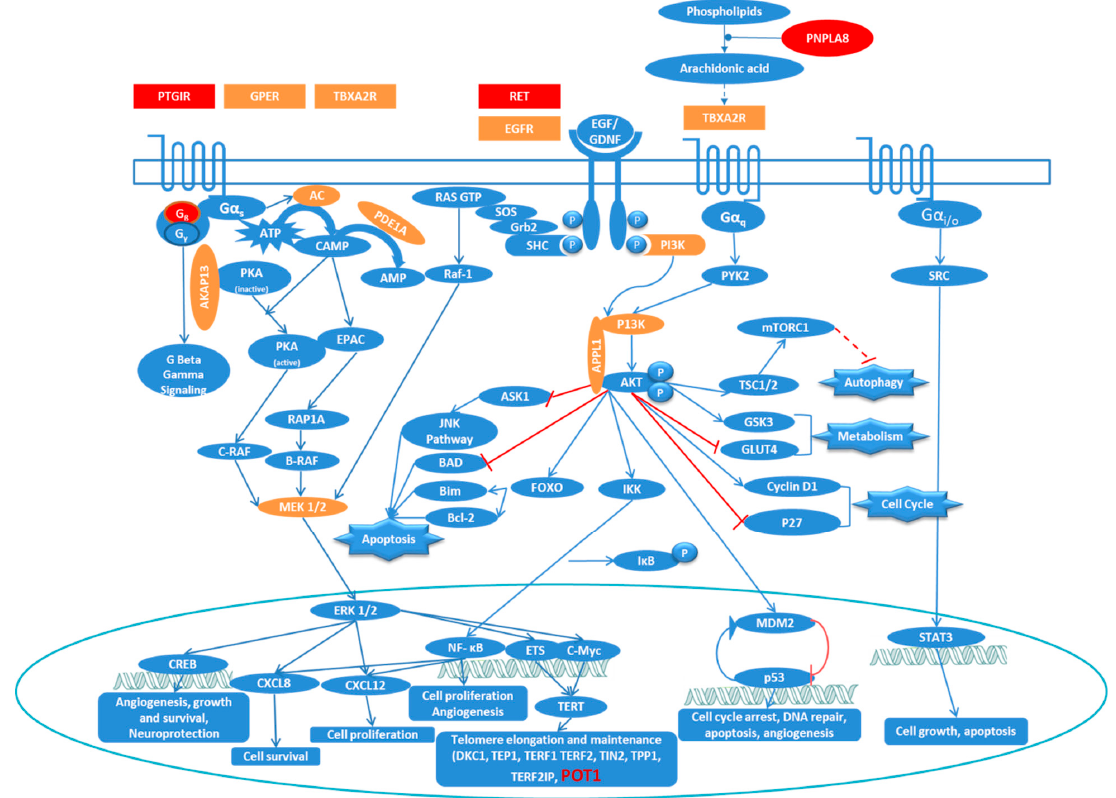
Figure 5. Proposed model for the most important molecular mechanisms in FNMTC. Genes from our input-data are highlighted in orange and genes corresponding to variants prioritized using the FCVPPv2 are highlighted in red.